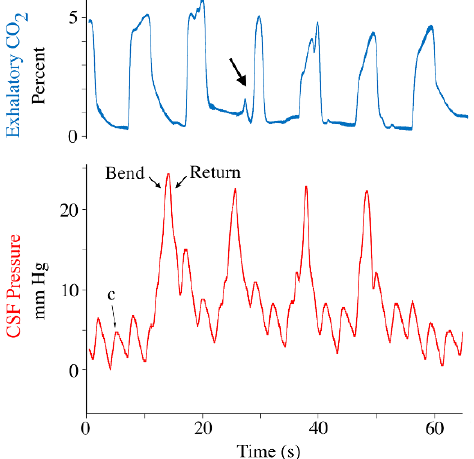
Figure 6. The influence of manual deflection of the body on CSF pressure. When the anesthetized alligator was bent to one side (see Supplemental video S1) there was a marked increase in CSF pressure (red). The exhalatory airflow (blue) was generally not changed during the bends, but some of the cycles were shortened and smaller spikes of airflow were observed (arrow). c—individual cardiac-related pulsation.